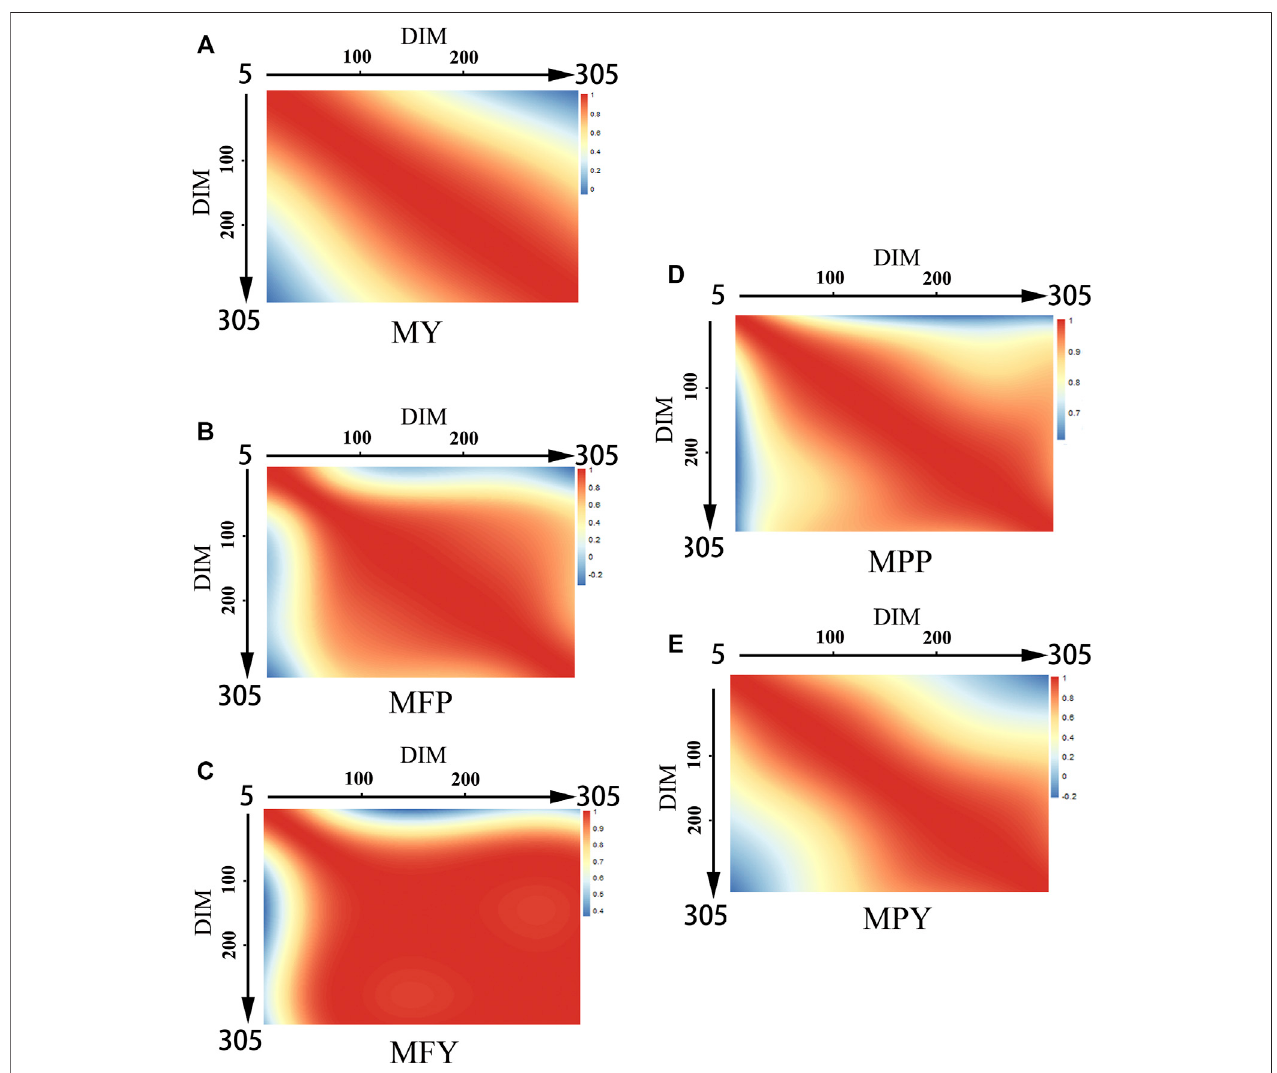
FIGURE 2 | Genetic correlations of milk-related traits in different DIM during lactation ( (A) MY, milk yield; (B) MFP, milk fat percentage; (C) MFY, milk fat yield; (D) MPP, milk protein percentage; (E) MPY, milk protein yield).